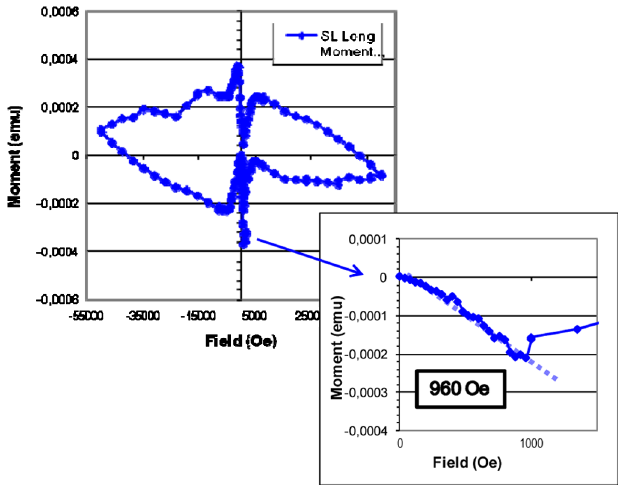
FIG. 4. Magnetization curves at 4.5 K for the SL sample (25 nm NbN top layer): longitudinal moment. The inset shows the determination of the first penetration field B P .